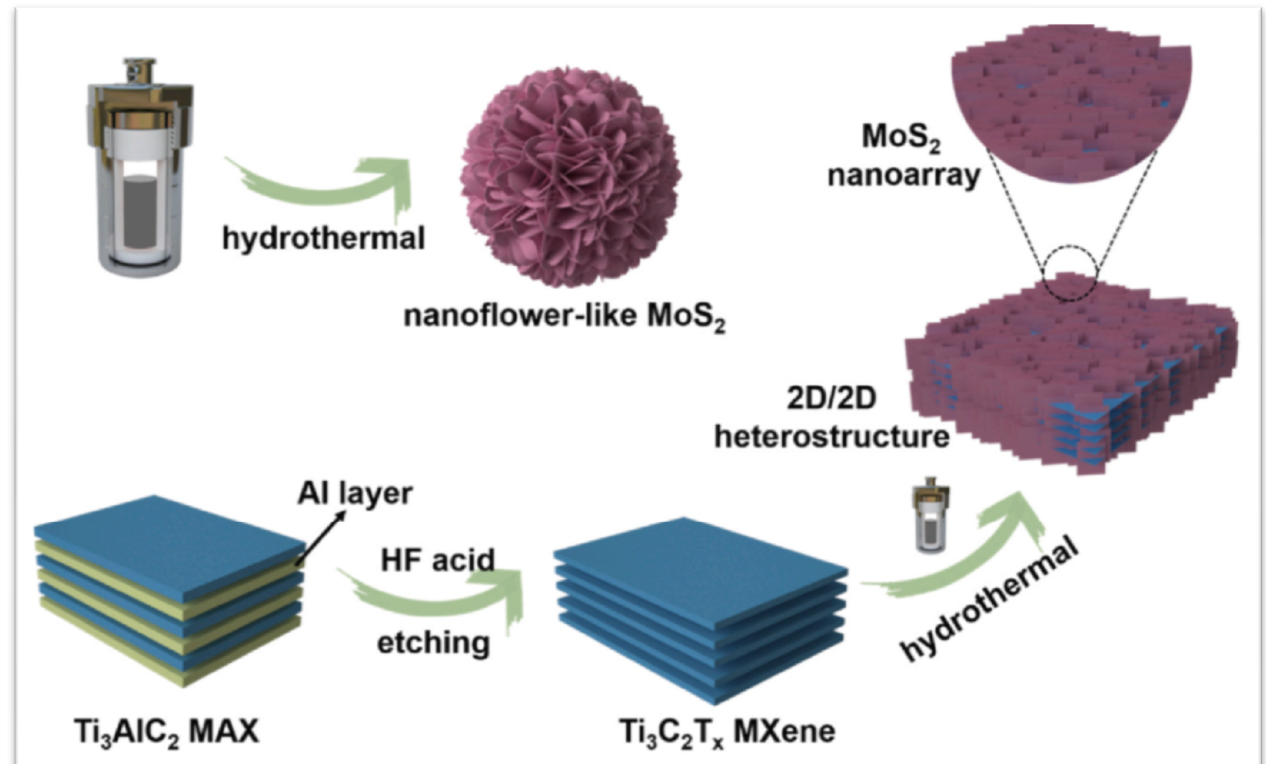
Figure 8. Illustration of the preparation process of MXene-MoS 2 . Reproduced with permission from [85]. Copyright 2021 Elsevier. from [85]. Copyright 2021